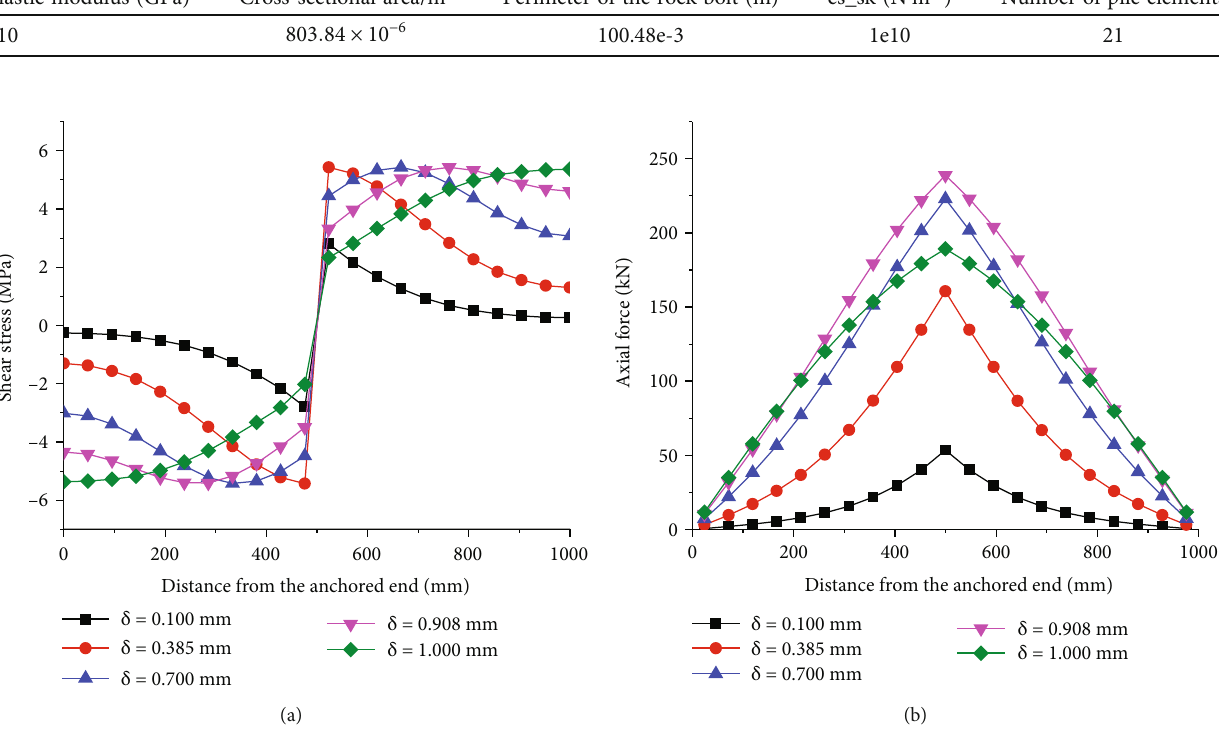
Figure 8: (a) The interfacial shear stress and (b) axial force distribution curves with single bedding